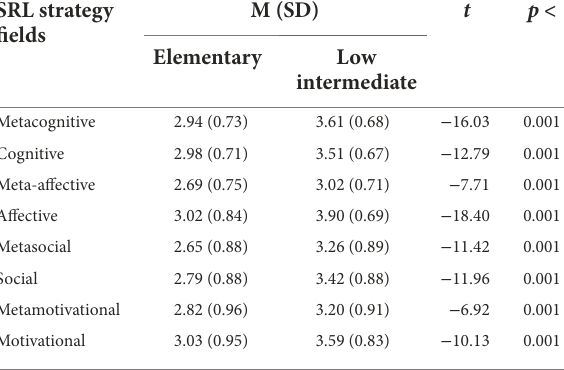
TABLE 4 Descriptive indicators of strategy fields.